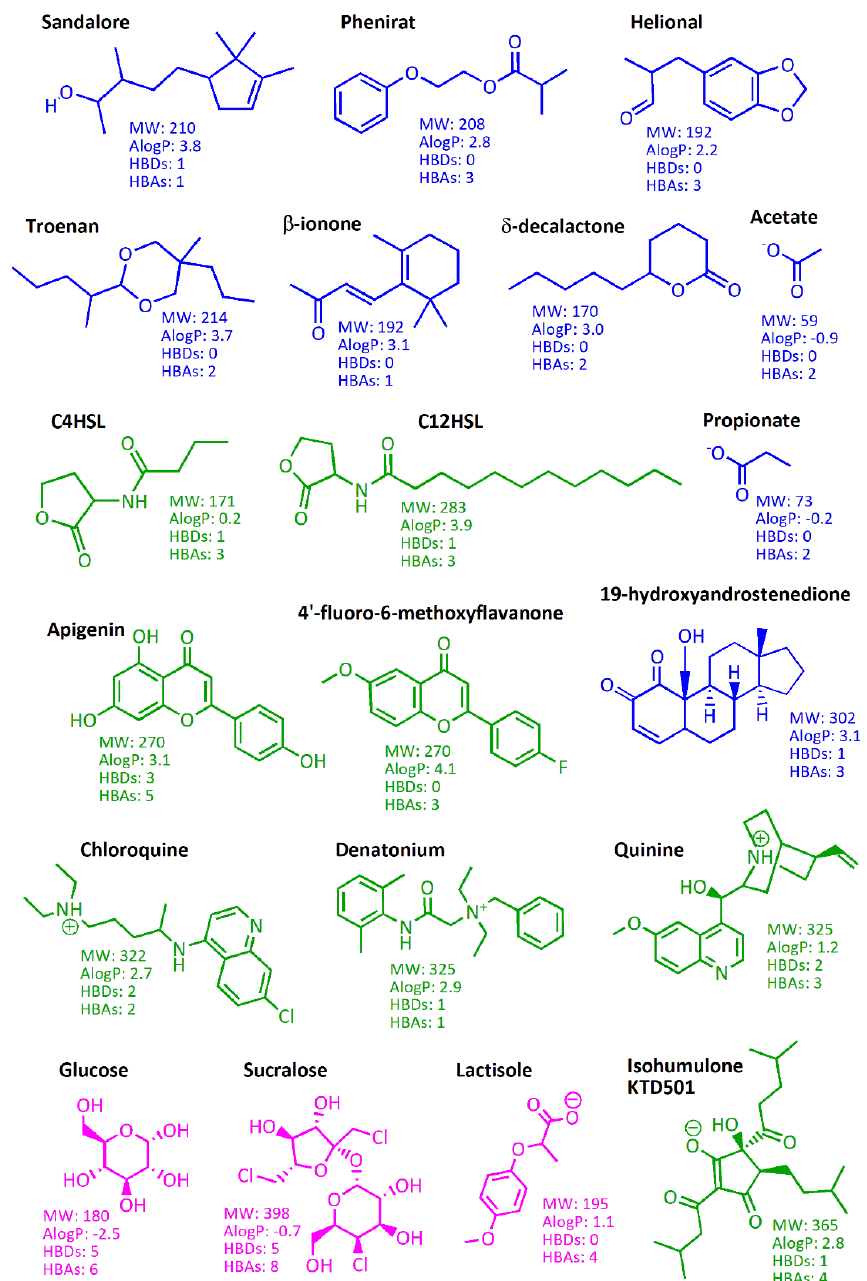
Figure 2. Chemical structures and physicochemical properties of csGPCR ligands. Odorant receptor (OR), TAS2R and TAS1R ligands are coloured in blue, green and magenta, respectively. MW (Molecular Weight), AlogP (octanol/water partition coefficient), HBDs (Hydrogen Bond Donors) and HBAs (Hydrogen Bond Acceptors) values at physiological pH have been calculated with Maestro (Schrödinger Release 2018-4: Maestro, Schrödinger, LLC, New York, NY, 2018).